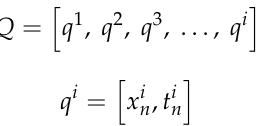
Figure 1. UWB antenna element: ( a ) front view; ( b ) back view. Table 1. Antenna Element Dimensions.